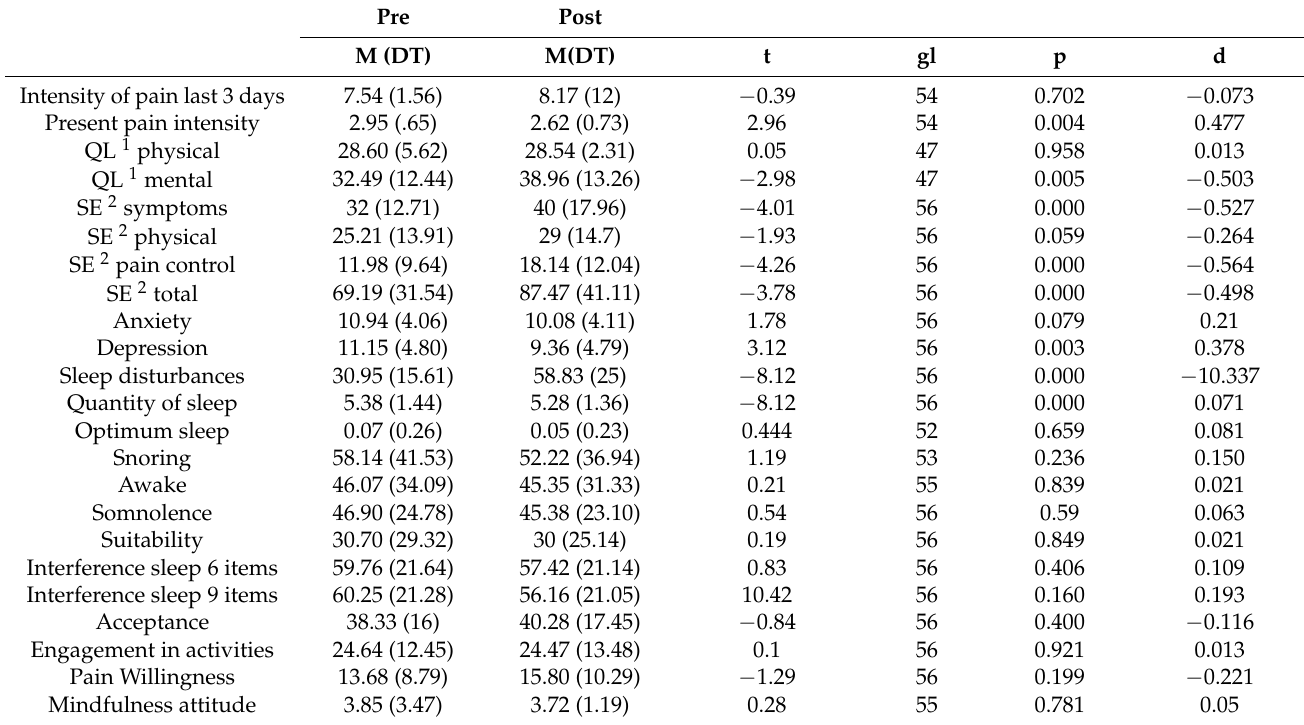
Table 3. t -test and Cohen’s d